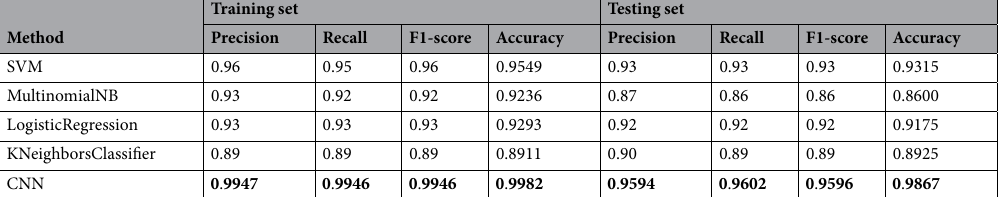
Table 2. Results of different methods, where “CNN” indicates the performance of the proposed model.